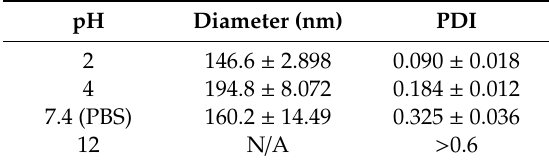
Table 1. Size (diameter) and size distribution (PDI) of tannic acid (TA)-chitosan particles as a function of pH measured by dynamic light scattering. Acidic media was achieved with the appropriate concentration of hydrochloric acid; basic media was achieved with the appropriate concentration of sodium hydroxide; pH 7.4 was achieved using phosphate bu ff ered saline